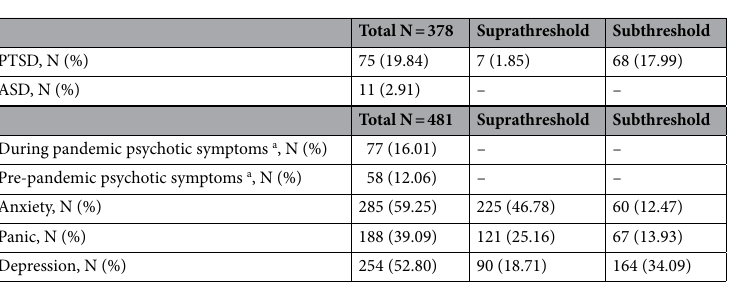
Table 2. Prevalence rate of psychopathological symptoms according to DSM-5 criteria. a Not due to substance